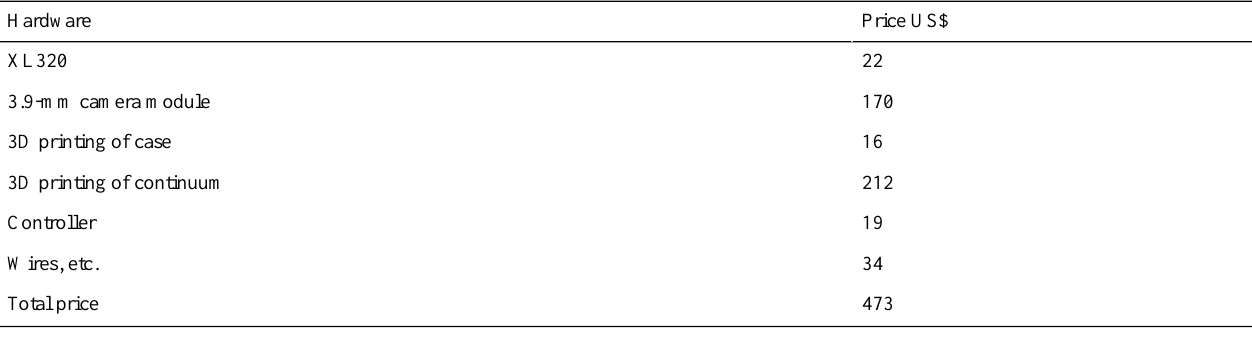
Table 1. Hardware prices of the articulable endoscope device.